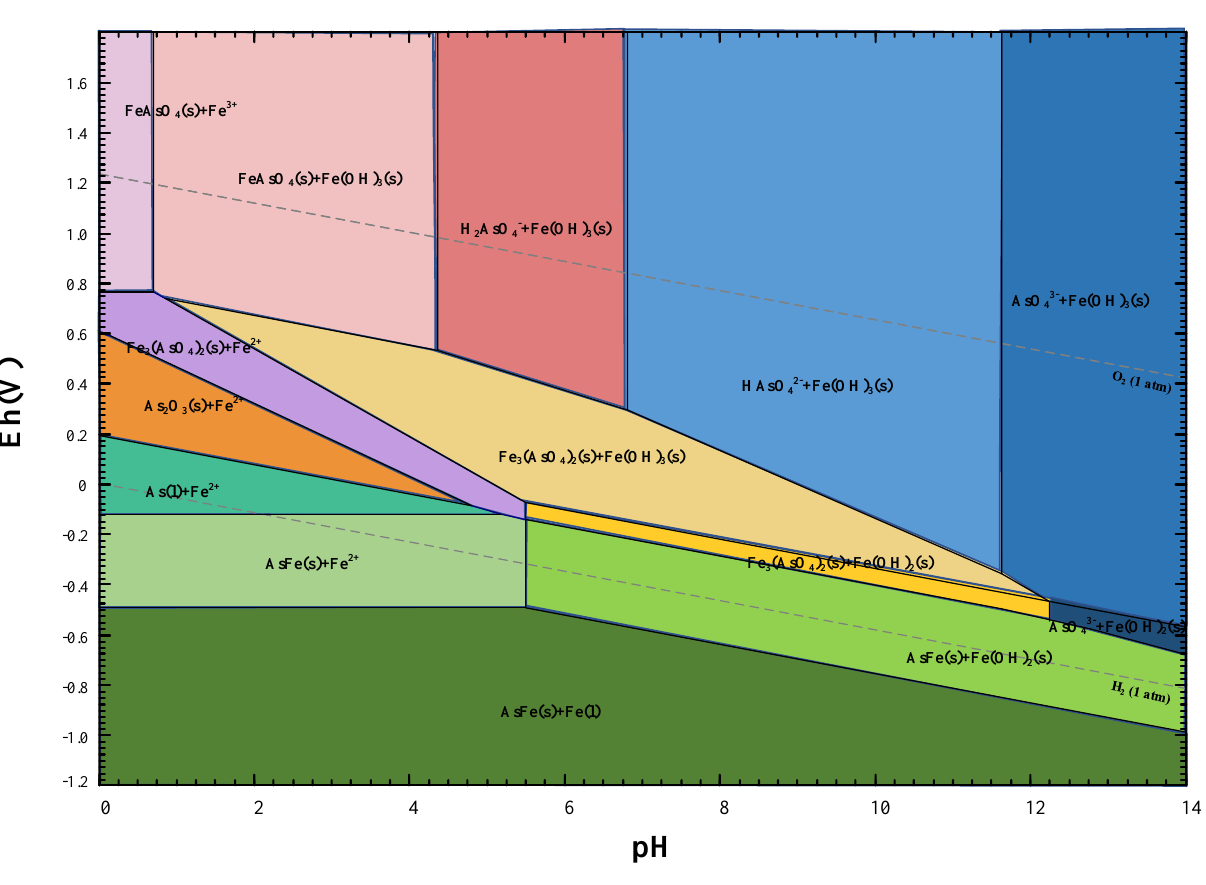
◦ C and atmospheric